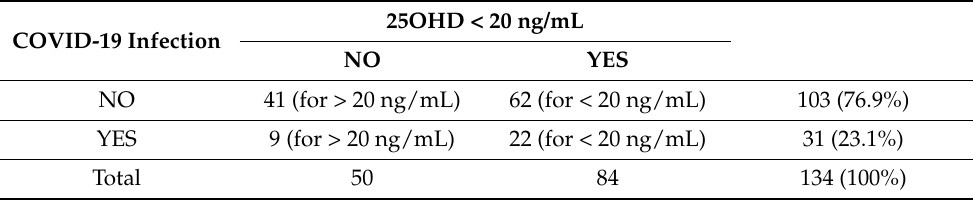
Table 2. Distribution analysis of subsequent cases of COVID-19 infections in healthy subjects during 12 months observation period, stratified according to vitamin D (25OHD) concentrations above or below 12 ng/mL (30 nmol/L) in spring 2020. The difference is statistically significant, p = 0.0063, χ 2 test. 25OHD < 12 ng/mL COVID-19 Infection NO YES NO 89 (for > 12 ng/mL) 14 (for < 12 ng/mL) 103 (76.9%) YES 20 (for > 12 ng/mL) 11 (for < 12 ng/mL) 31 (23.1%) Total 109 25 134 (100%) Table 3. Distribution analysis of subsequent cases of COVID-19 infections during 12 months obser- vation period in healthy subjects, stratified according to vitamin D (25OHD) concentrations above or below 20 ng/mL (50 nmol/L) in spring 2020. The difference was not statistically significant, p = 0.2787, χ 2